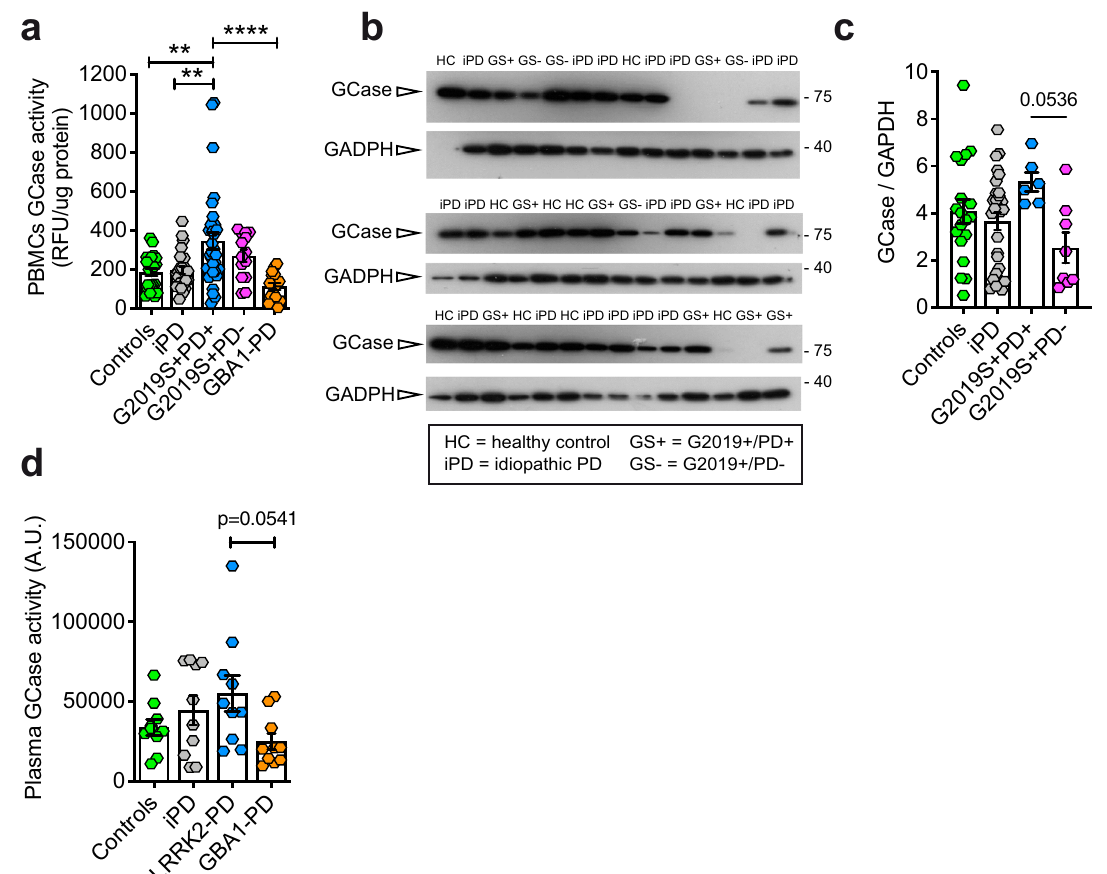
Fig. 2 GCase activity and level measured in PBMCs and plasma from idiopathic PD patients, in LRRK2 G2019S unaffected carriers and patients, in GBA1 PD patients compared with controls. a GCase activity (normalized to total protein content) measured in PBMC extracts from the indicated PD cohort. While GCase activity in GBA1 mutation carriers is reduced, activity in affected G2019S-LRRK2 carriers is signi fi cantly elevated (one-way ANOVA, Tukey ’ s post-hoc tests; ** p < 0.01, **** p < 0.0001; data are expressed as mean ± SEM). b GCase protein level as evaluated by western blot analysis in a subset of PBMCs for which the activity was evaluated (HC = healthy controls; iPD = idiopathic PD; GS + = LRRK2 G2019S carriers affected by PD; GS − = LRRK2 G2019S carriers non-affected by PD; data are expressed as mean ± SEM). Note that samples showing absence of a GCase band were excluded from the analysis. c Quanti fi cation of GCase levels in PBMCs showing a non- signi fi cant increase in GS + PBMCs compared to GS − (One-way ANOVA, Tukey ’ s multiple comparisons test, GS + PD + vs. GS + PD − p = 0.0536; data are expressed as mean ± SEM). d GCase activity normalized by the total protein content measured in the plasma of idiopathic patients, in patients carrying LRRK2 G2019S mutations or GBA1 mutations. The trend is similar between plasma samples and PBMCs (10 individuals for each group; one-way ANOVA, Tukey ’ s multiple comparisons test; GS + PD + vs. GBA1-PD p = 0.0541; data are expressed as mean ± GCase activity is increased in iPSC-derived dopaminergic neurons from G2019S LRRK2 patients We next evaluated the role of LRRK2 kinase activity on GCase function in a human-derived disease-relevant model. To this aim, we took advantage of iPSC-derived dopaminergic neurons. iPSC lines of PD patients and controls stained positive for stem cell markers (SOX2, OCT4, TRA-1 – 60, SSEA4). Karyotype analysis excluded genetic abnormalities of reprogrammed iPSCs. Dopami- nergic neurons differentiated from all iPSC lines cultured up to 70 days in vitro-stained positive for neuronal (TUJ1) and dopaminergic (TH, DAT) markers, con fi rming appropriate differ- entiation (Fig. 4a). The ef fi ciency of dopaminergic neuron differentiation with this protocol was described in ref. 26 : >55% of TUJ1-positive cells are also positive for the catecholaminergic marker TH and no differences in DA neuron yields across lines and batches of differentiation was observed. As a fi rst screen, we measured GCase activity in iPSC-derived neurons carrying mutations in different PD genes, i.e., GBA1 (L444P), LRRK2 (G2019S) and compared to fi ve different healthy controls. In line with results obtained in PBMCs, and as expected,